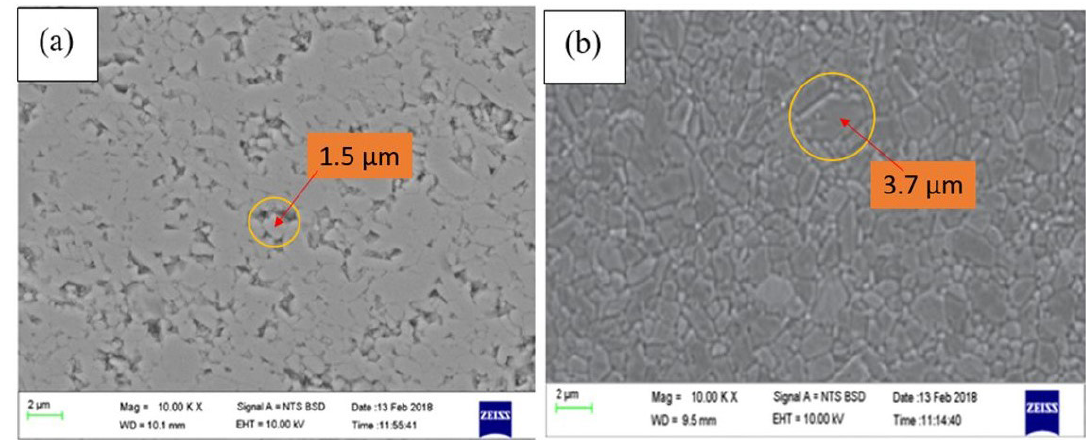
O -SiC composites as a function of sintering temperature 2 3